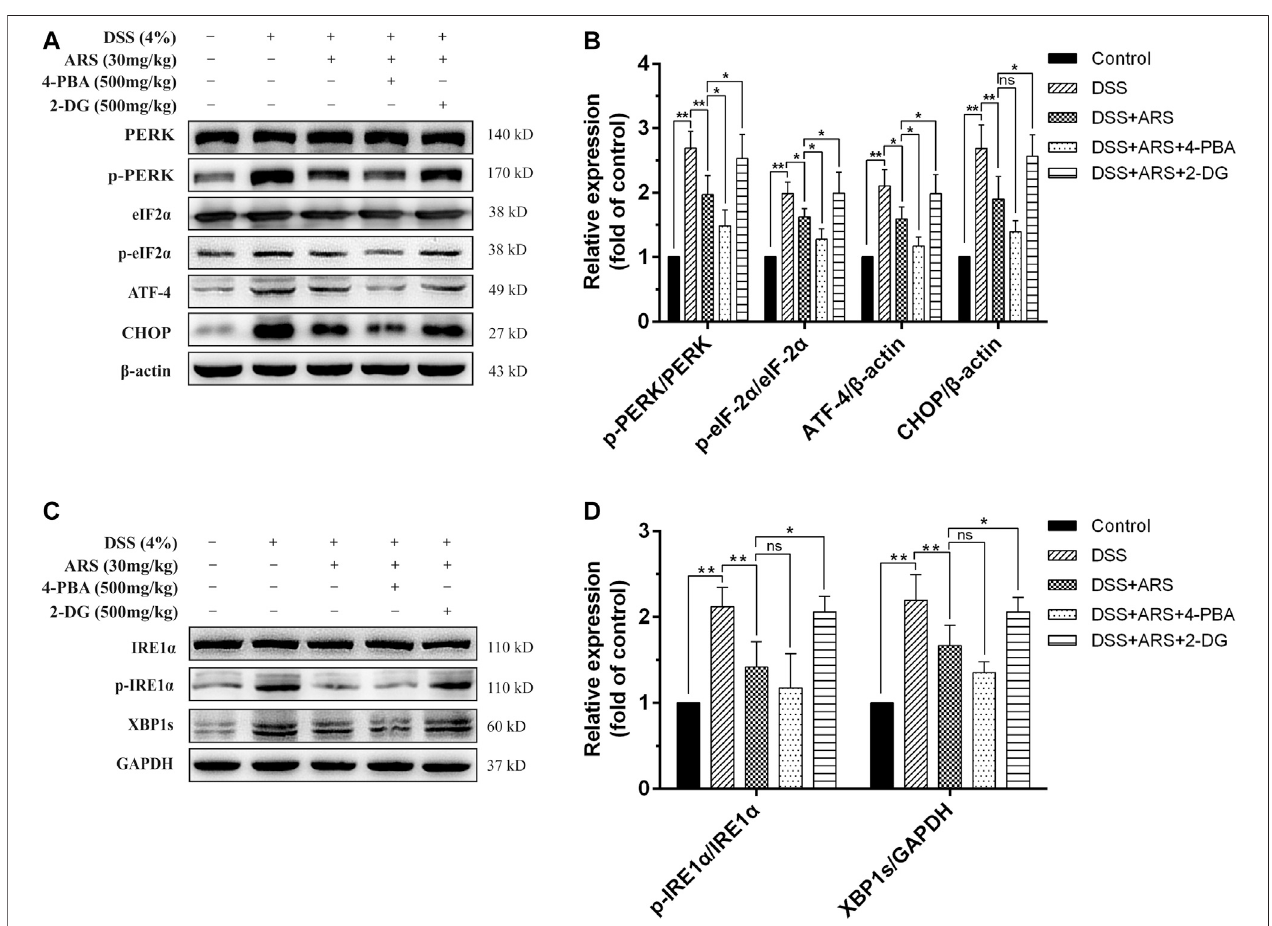
FIGURE3| Effectof4-PBAand2-DGontheinhibitoryroleofARSinDSS-inducedERstress. (A) TheimmunoblotanalysisofmajorproteinsinPERK-eIF2 α -ATF4- CHOP signaling pathway. (B) Quanti fi ed results from (A) . (C) The expression levels of major proteins in IRE1 α -XBP1 signaling pathway were assessed by western blot. (D) Quanti fi ed results from (C) . Data are presented as mean ± SD ( n (cid:1) 3). * p < 0.05, ** p < 0.01.